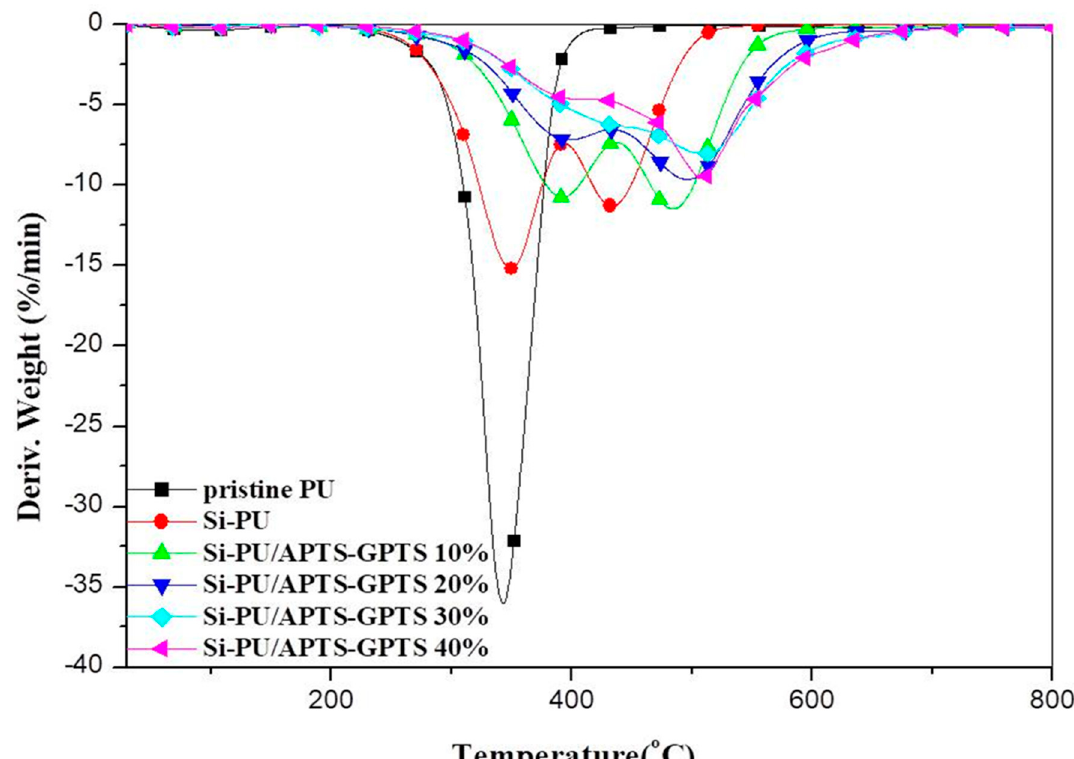
Figure 6. TGA curves of Pristine PU and Si-PU / APTS-GPTS composites in N 2 .